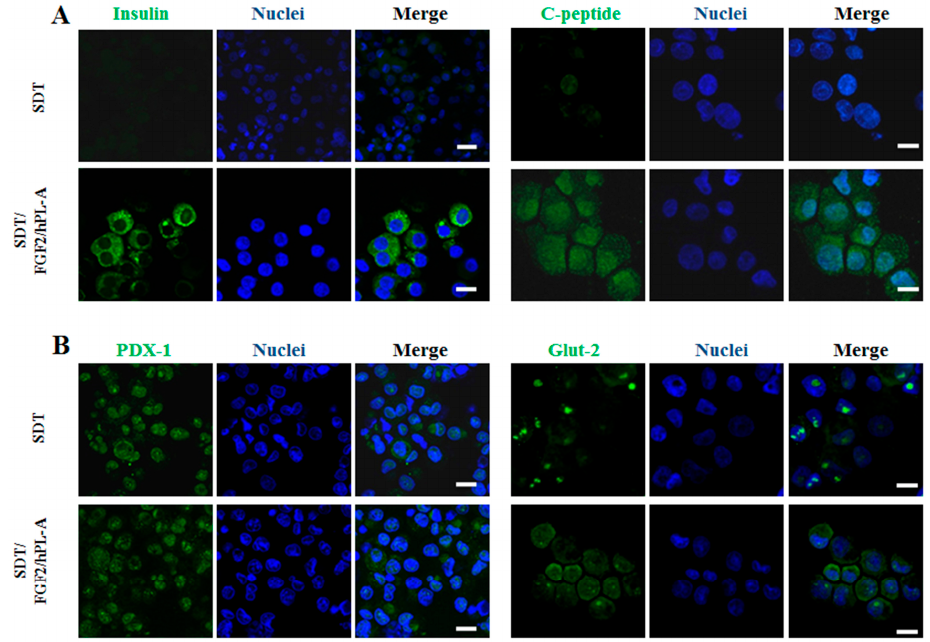
Figure 2. Confocal microscopy analysis of islet-like aggregates. Islet-like aggregates obtained after 96 h of treatment of PANC-1 cells with FGF-2b plus hPL-A were disaggregated to form single cell suspensions. Cells were then centrifuged with a cytospin on polilysine-coated slides and immediately fixed by paraformaldehyde 4%. After permeabilization, cells were green stained for: insulin and C-peptide ( A ); and glucose transporter 2 (Glut-2) and pancreatic and duodenal homeobox 1 (PDX-1) ( B ), while nuclei were blue-stained by Hoechst. Confocal microscopy analysis showed that treatment with FGF-2b plus hPL-A induced an increase of insulin and C-peptide staining in the cytosol, and a slight increase of PDX-1 staining in the nucleus and Glut-2 in plasma membrane. Scale bar = 20 μ m.